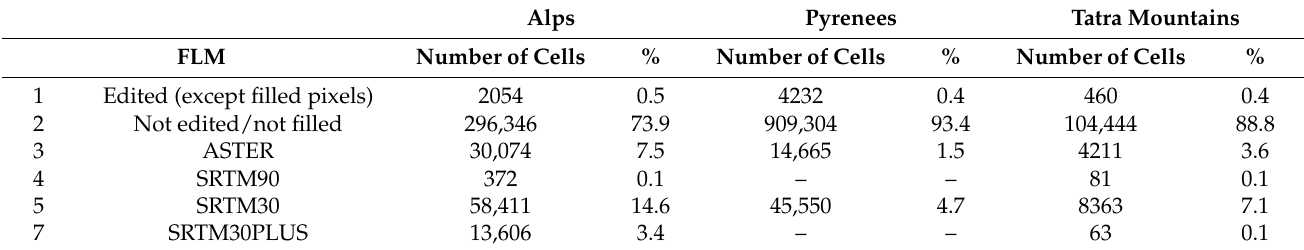
Table 6. Number of cells belonging to particular COP90 filling mask (FLM) categories. Alps Pyrenees Tatra